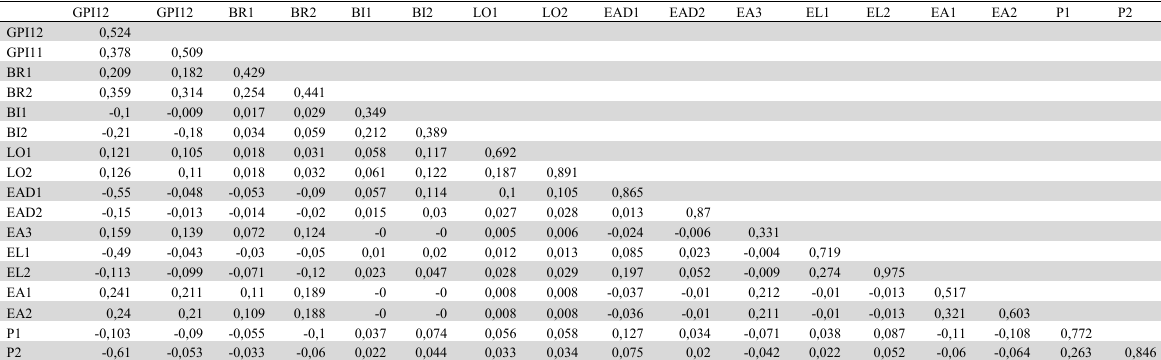
Standardized Residual Covariances GPI12